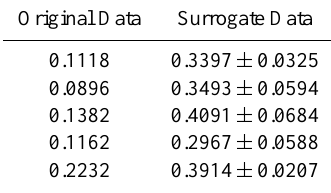
Table 2. Results of the surrogate data test for Lyapunov exponents for TEC data for the most disturbed days of October 2011 at Lagos